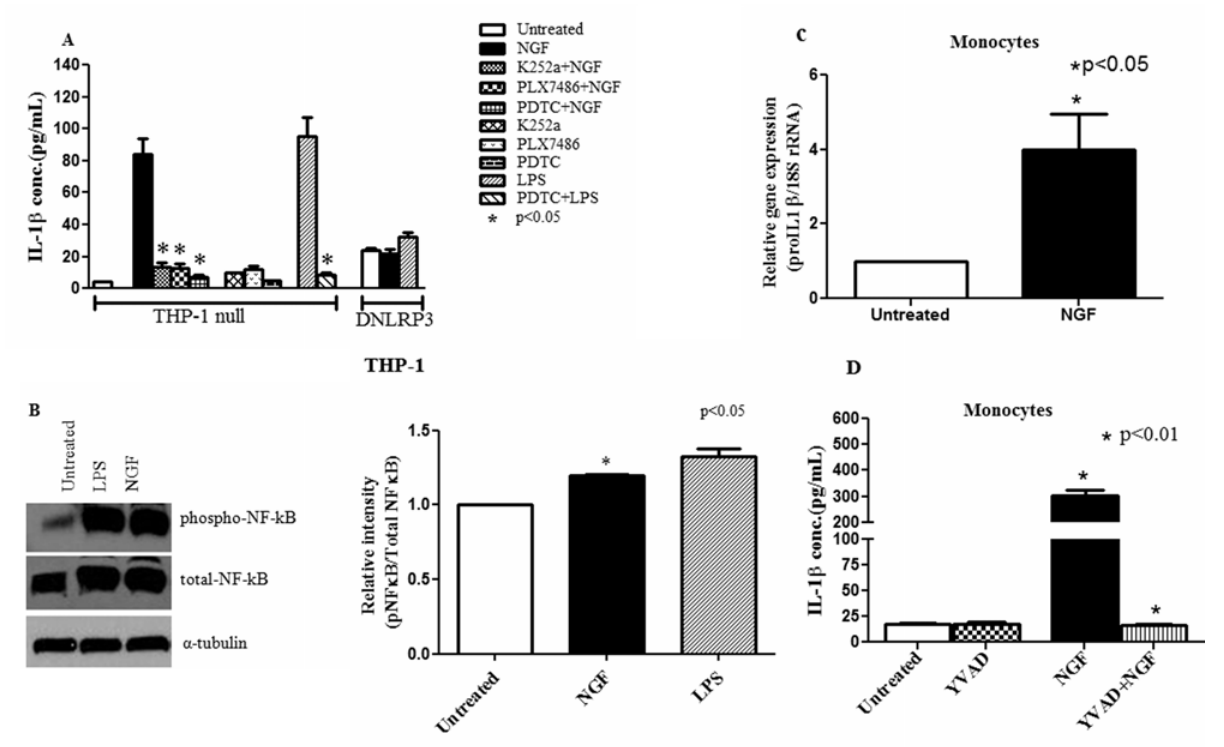
Fig 1. NGF/TrkA interaction induces IL-1 β at protein and mRNA level in monocytic cell line through NF- κ B. (A) In null THP-1 cells, NGF (100 ng/ml) significantly induced mature IL-1 β secretion compared to NLRP3 deficient THP-1 cells (DNLRP3). Prior treatment with TrkA inhibitors (K252a, 100 ng/ml and PLX7486, 100 ng/ml) or NF- κ B inhibitor, PDTC (50 μ M) effectively inhibited NGF induced IL-1 β release (n = 6). (B) Western blot assay was done with null THP-1 cells cultured for 24 hrs with NGF (100 ng/ml) and LPS (1 μ g/ml). Representative immunoblot and bar diagram (n = 6) showing significant phosphorylation of NF- κ B p65 with NGF. LPS was used as a positive control. (C) Real-time PCR was performed with total RNA extracted from human monocytes cultured for 24 hrs with NGF (n = 8). NGF significantly upregulated IL-1 β mRNA. (D) Magnetically sorted monocytes (n = 12) were cultured with or without NGF (100 ng/ml) and caspase-1 inhibitor (YVAD, 50 μ M). Bar diagram showing significant induction of IL-1 β with NGF and YVAD effectively blocked it. Data expressed as Mean ± SEM. Mann Whitney U test was done to determine statistical